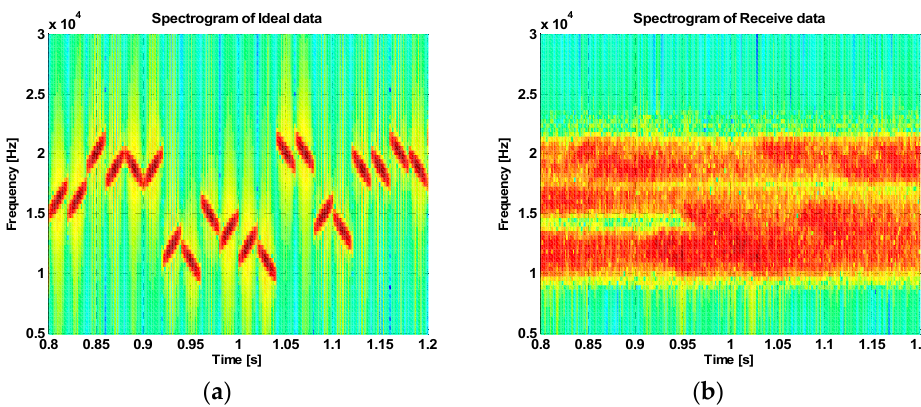
Figure 16. Spectrogram of ( a ) the transmitted signal, and ( b ) the received signal in the second trial.